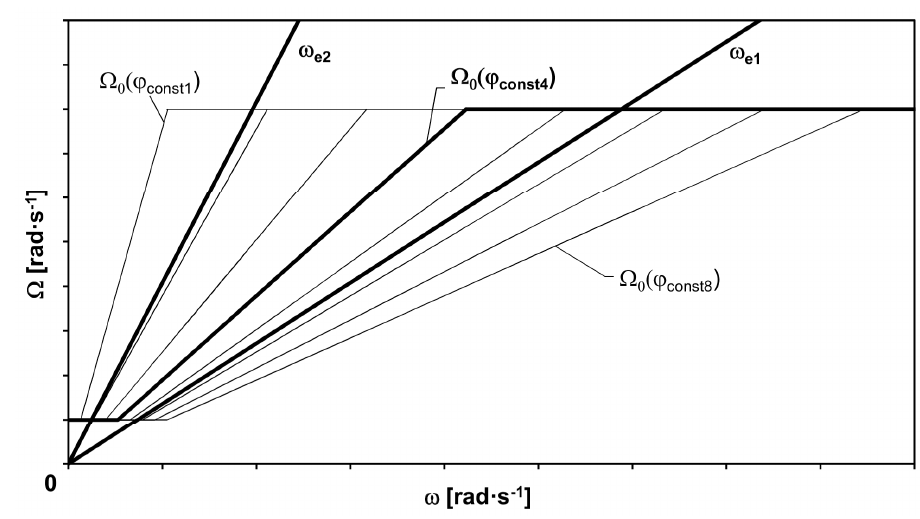
Figure 4. Interference diagram of a mechanical system with constant twist angle